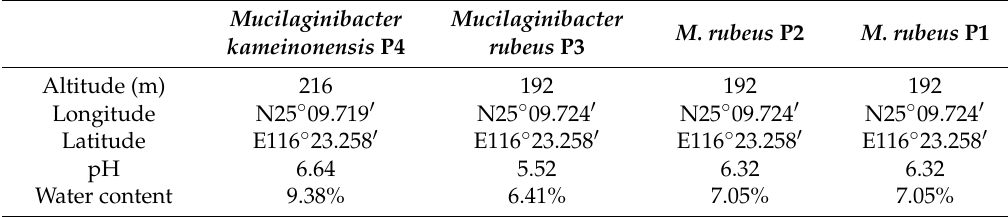
Characteristics of the heavy metal (HM)-contaminated soil from where the strains were isolated. Mucilaginibacter Mucilaginibacter M. rubeus kameinonensis P4 rubeus P3